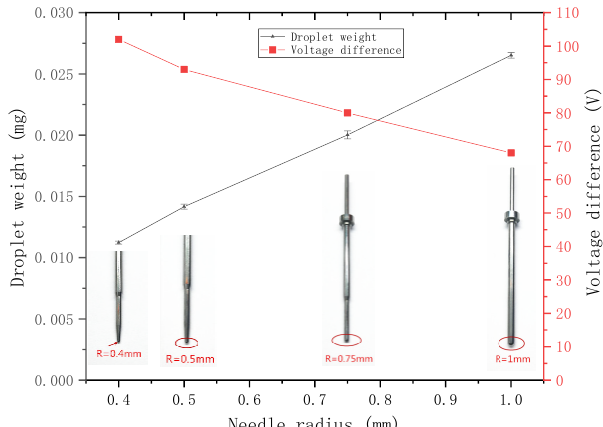
Figure 15. Relationship between the droplet weight, the minimum voltage difference, and the needle radius.